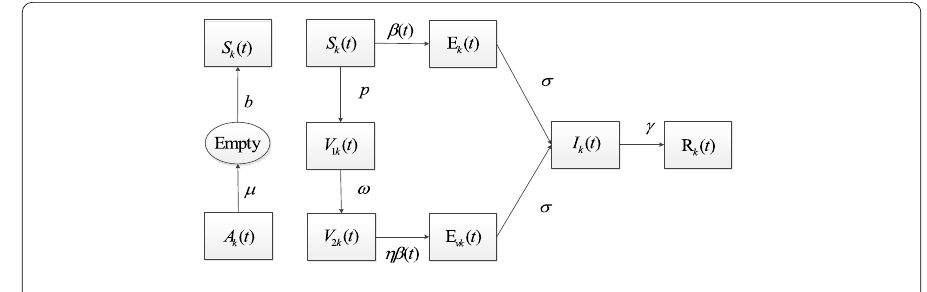
Figure 1 The flow diagram of the measles transmission on the network model ( A k = S k + V 1 k + V 2 k + E k + E vk + I k + R k